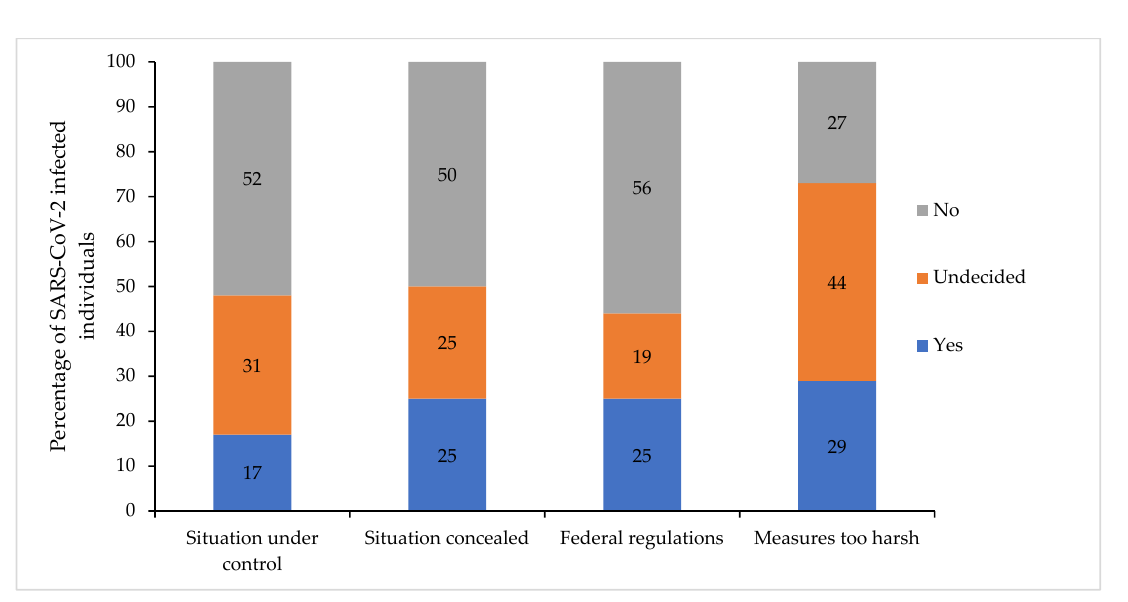
Figure 2. Attitudes toward the government’s regulations ( n = 224).